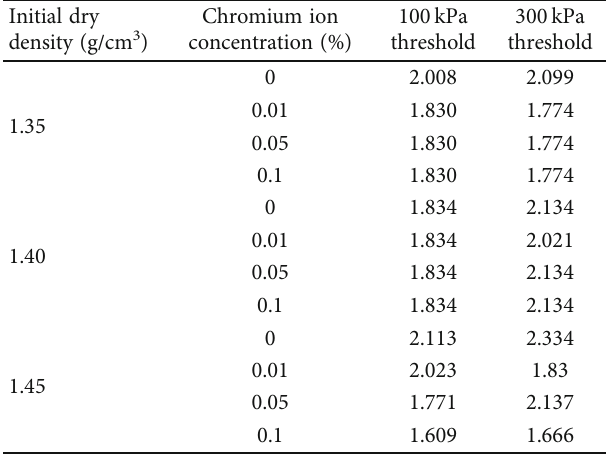
Table 8: Strain threshold of chromium-contaminated red clay under di ff erent conditions